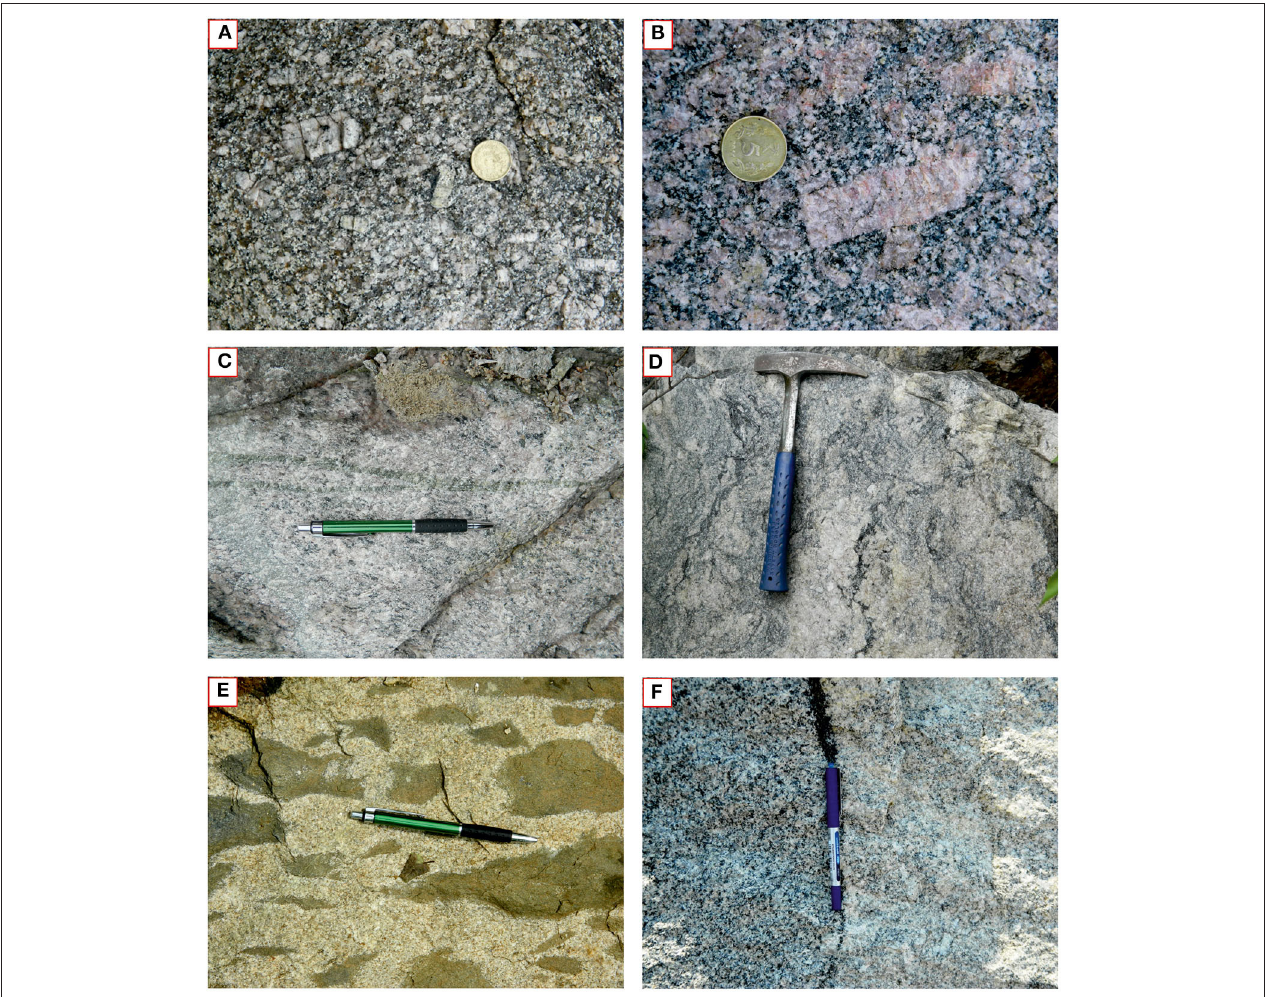
FIGURE 2 | Field photographs of different granite types from Kanker (A) Gray porphyritic granite with feldspar phenocryst. (B) Pink porphyritic granite with alkali feldspar phenocrysts. Both these granitoids are high in mafic minerals. (C) Medium- to coarse-grained leucogranite being intruded by an epidote vein. (D) Gray medium- to coarse-grained anatectic granite. (E) Medium to coarse- grained gray granite with abundant Magmatic Enclaves (MEs). (F) Two granitoid variants that differ in their mafic mineral contents, demarcated by a sharp boundary of biotite